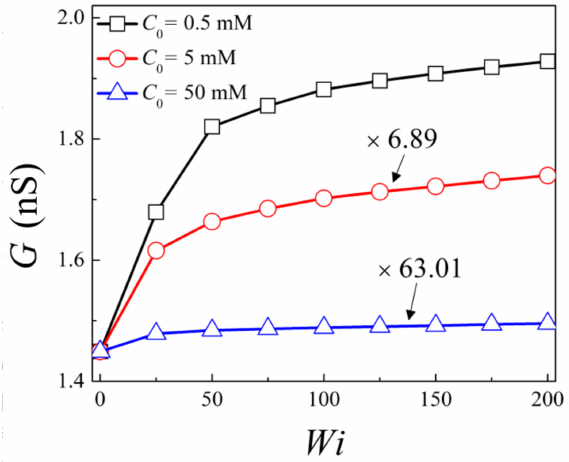
Figure 4. Variation of ionic conductance with Weissenberg number for C 0 = 0.5 mM, 5 mM, and 50